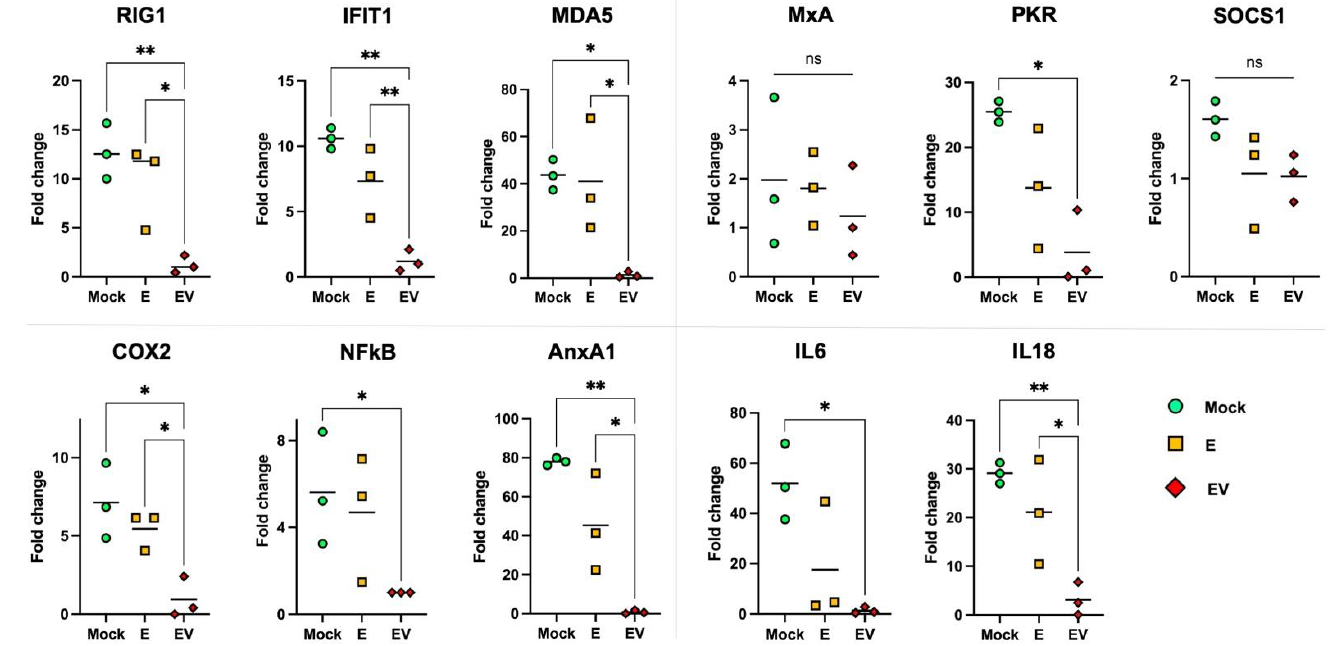
Figure 4. Expression profile changes in E- and EV-treated cells. Three separate stimulations of cells (by pooled E and EV samples) were performed. Data are presented as measured points and mean value. ‘Mock’ (control cells)—mock-treated A549 cells. All fold changes were calculated considering the mean gene expression in EV as 1. Statistical analysis was performed using one-way ANOVA: ** — p < 0.01; * — p < 0.05, ‘ns’— p > 0.05 (not significant).